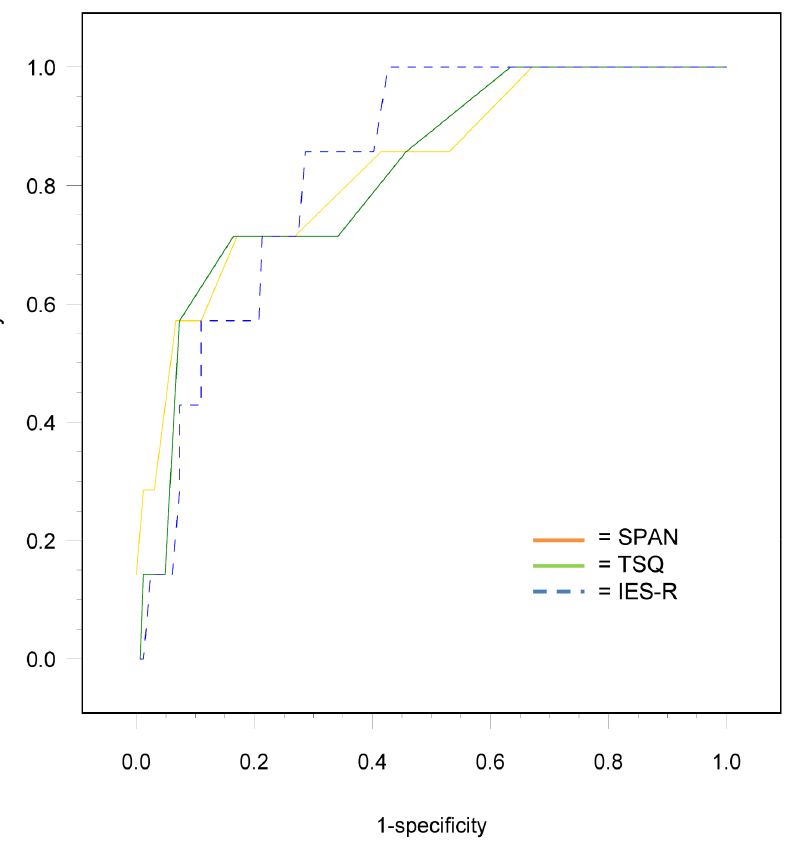
Figure 2. ROC curves of the SPAN, TSQ and IES-R for 6 month PTSD. Note: ROC curves represent original sensitivity and specificity values using linear interpolation between the observed data points. ROC, Receiver Operating Characteristic; SPAN, Startle, Physiological Arousal, Anger &